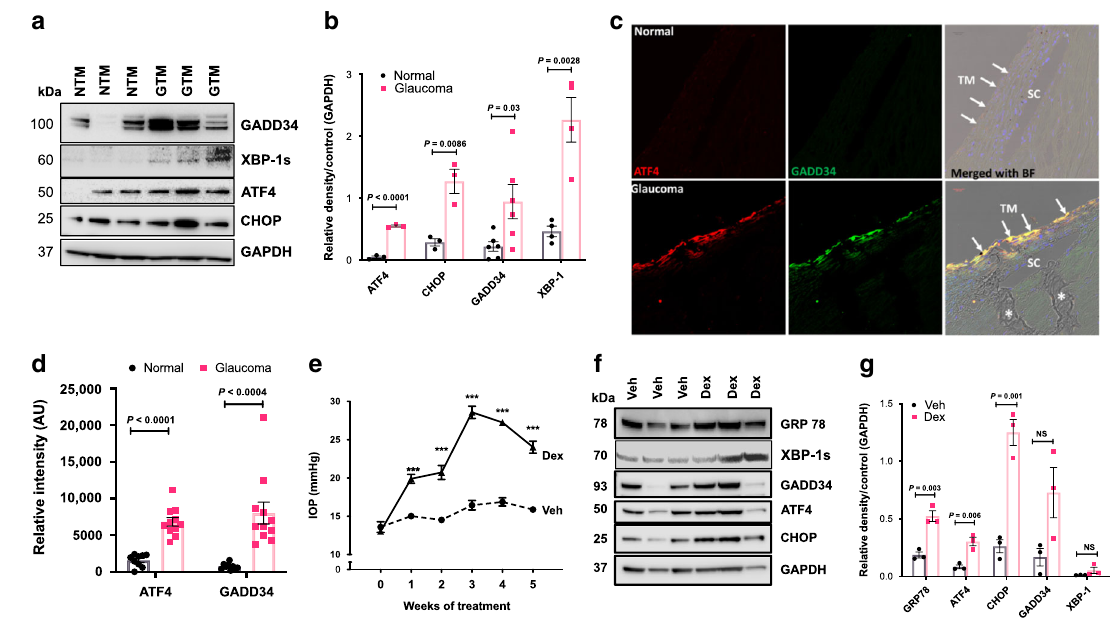
Fig. 1 ATF4 – CHOP – GADD34 is induced in TM cells/tissues of human and mouse glaucoma. a and b Cellular lysates from age-matched normal and glaucomatous primary human TM cells were examined for ER stress markers using Western blotting a and analyzed by densitometric analysis b . The average from two independent experiments is shown graphically ( n = 3 cell strains for ATF4 and CHOP; n = 6 cell strains for GADD34; n = 4 cell strains for XBP-1; data are presented as mean ± SEM, 2-tailed unpaired t -test). c and d Representative immunostaining for ATF4 and GADD34 c and its intensity measurements d in age-matched normal and glaucoma donor eyes shows signi fi cantly increased ATF4 and GADD34 in glaucomatous TM tissues. Arrow shows TM. SC Schlemm ’ s canal. Scale bar is 100 µ m ( n = 9 normal and 11 glaucoma eyes, data are presented as mean ± SEM, two-tailed unpaired t -test). *Indicates fold in section (artifact). e Periocular Dex injections elevate IOP signi fi cantly in C57BL/6J mice. 3 months old C57BL/6J mice received vehicle or Dex (200 µ g/eye) via periocular conjunctival fornix injections bilaterally every week up to 5 weeks and night IOPs were monitored weekly using rebound tonometry ( n = 8 in each group; data are presented as mean ± SEM, two-way ANOVA, ***P < 0.001). f and g Western blot for ER stress markers f and its densitometric analyses g of anterior segment tissues from vehicle and Dex-treated mice demonstrated that induction of chronic ER stress markers is associated with Dex-induced ocular hypertension ( n = 3 in each group, data are presented as mean ± SEM, two-tailed unpaired t -test).